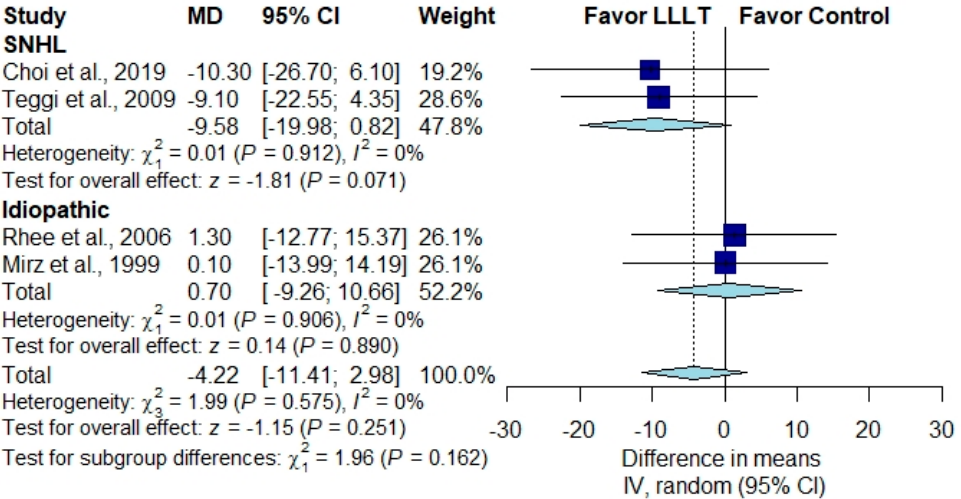
Figure 5. Subgroup analysis of rating scale score improvement in patients with SNHL and patients with idiopathic tinnitus [23–26,31] . 3.3.4. Subgroup Analysis According to the Number of Irradiation Sessions In studies in which effect estimates were measured by THI score, two studies with more than the median number of irradiation sessions showed no significant difference between the LLLT group and the placebo group [28,29] (Figure 6) (MD, − 3.59; 95% CI, − 13.23 to 6.05; p = 0.465; I 2 = 15%), while another three studies with fewer than the median number of sessions showed no significant difference between the two groups [1,30,31] (Figure 6) (MD, − 2.26; 95% CI, − 10.77 to 6.25; p = 0.362; I 2 = 0%). In studies in which effect estimates were measured by the improvement rate of the rating scale scores, four studies with more than the median number of irradiation sessions revealed no significant difference between the two groups [25–27,32] (Figure 7) (RR, 1.40; 95% CI, 0.75 to 2.60; p = 0.294; I 2 = 71%), neither did another two studies with fewer than the median number of sessions [23,24] (Figure 7) (RR, 1.28; 95% CI, 0.34 to 4.85; p = 0.718; I 2 = 78%).